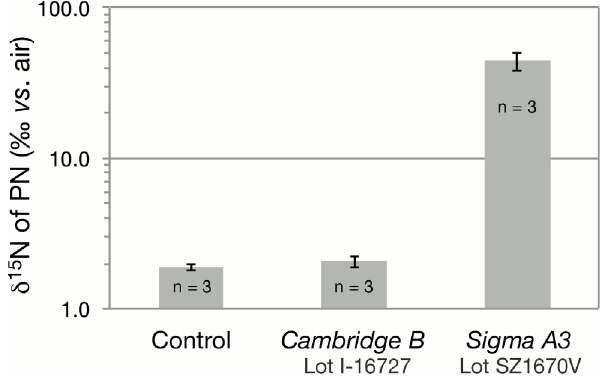
Figure 4. The d 15 N of particulate nitrogen ( d 15 N PN ) of D. tertiolecta harvested in stationary phase following growth in media containing sodium nitrate (and no ammonium) and equilibrated with 15 N 2 gas from Sigma Aldrich or Cambridge Isotopes. n=the number of experimental replicates.